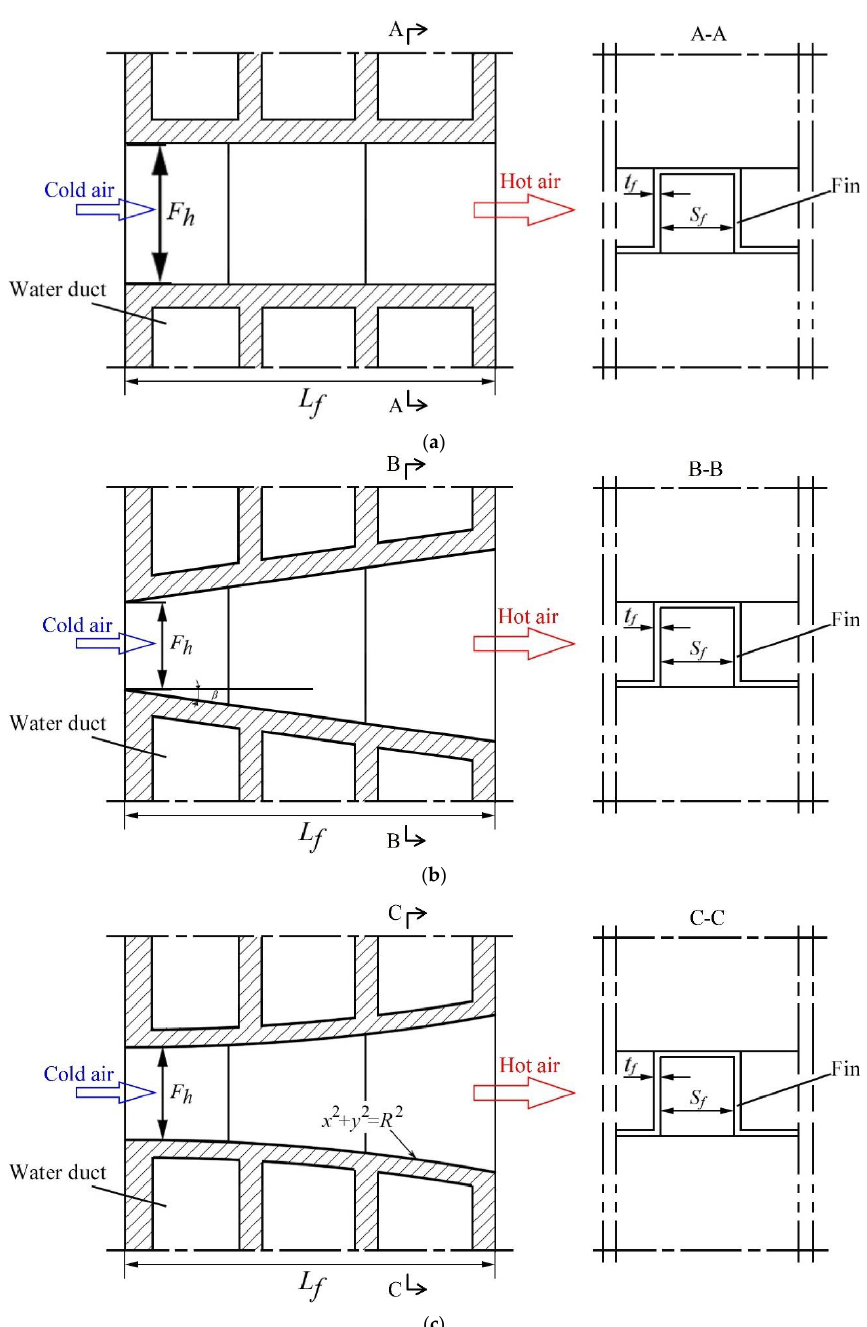
Figure 2. Schematic diagram of the structural parameters of the three flow channels. ( a ) Equal cross-section flow channel; ( b ) trapezoidal flow channel; ( c ) circular-arc-shaped flow channel [5]. Table 1. Parameter table for equal cross-section flow channels.